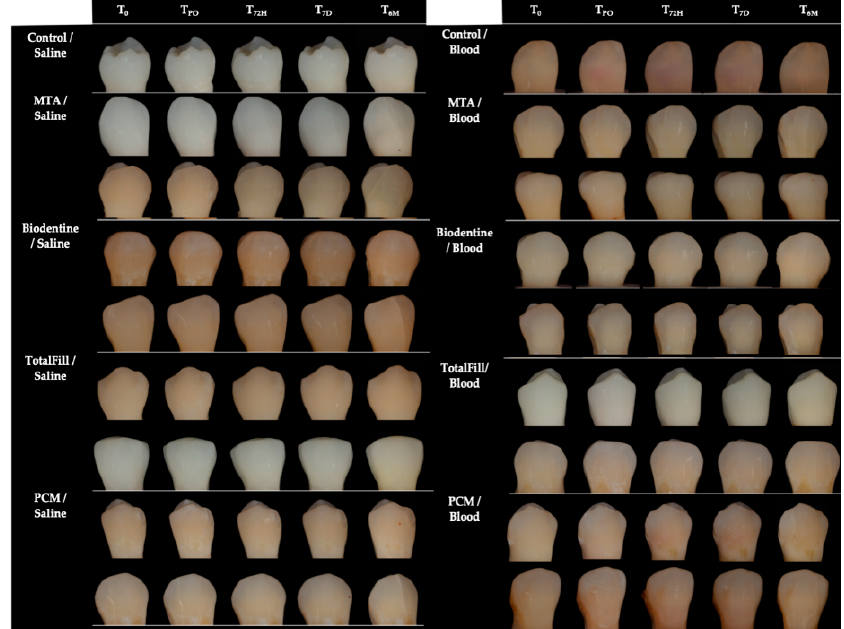
Figure 3. Color assessment of randomly selected representative samples from each experimental group at the five evaluated timeframes (T 0 , T PO , T 72H , T 7D , and T 6M ).